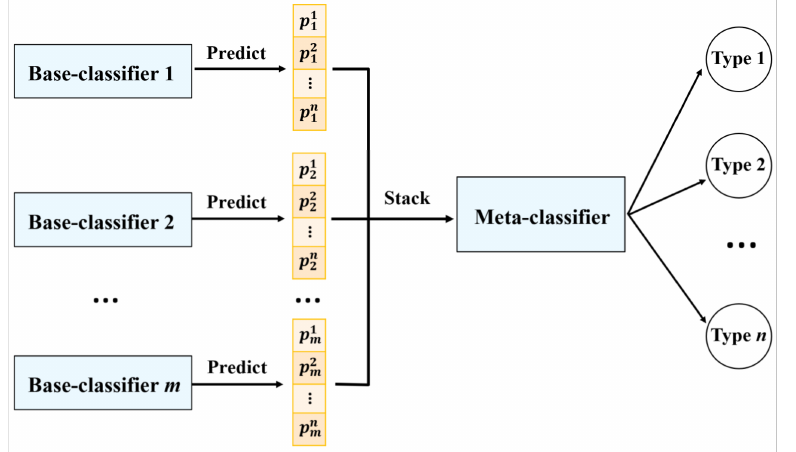
Figure 6. Details of the stacking ensemble learning process. p i of the input sample belonging to the i -th type that is predicted by the j-th base-classifier, and m and n denote the number of the based-classifiers and the number of junction pattern types,